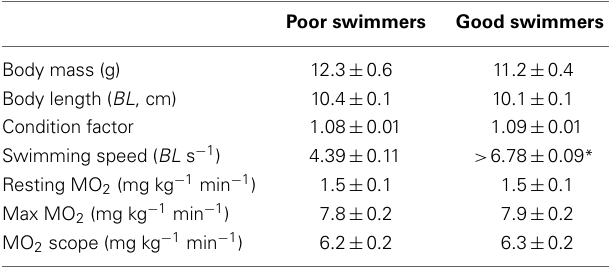
salmon parr swimmers measured at 12 ◦ C.